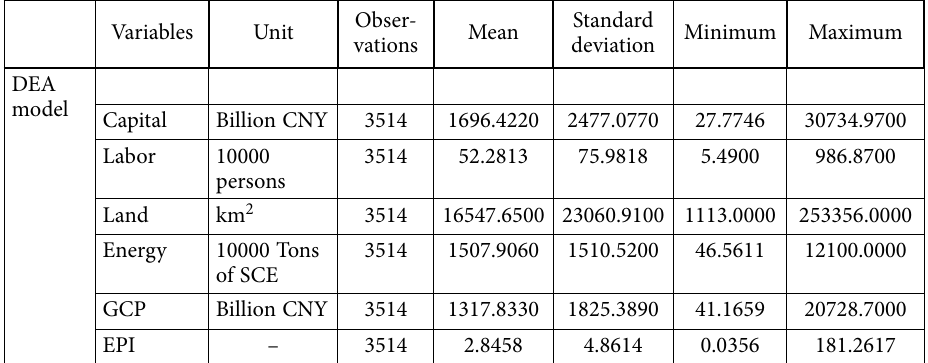
Table 1. Descriptive statistics of various